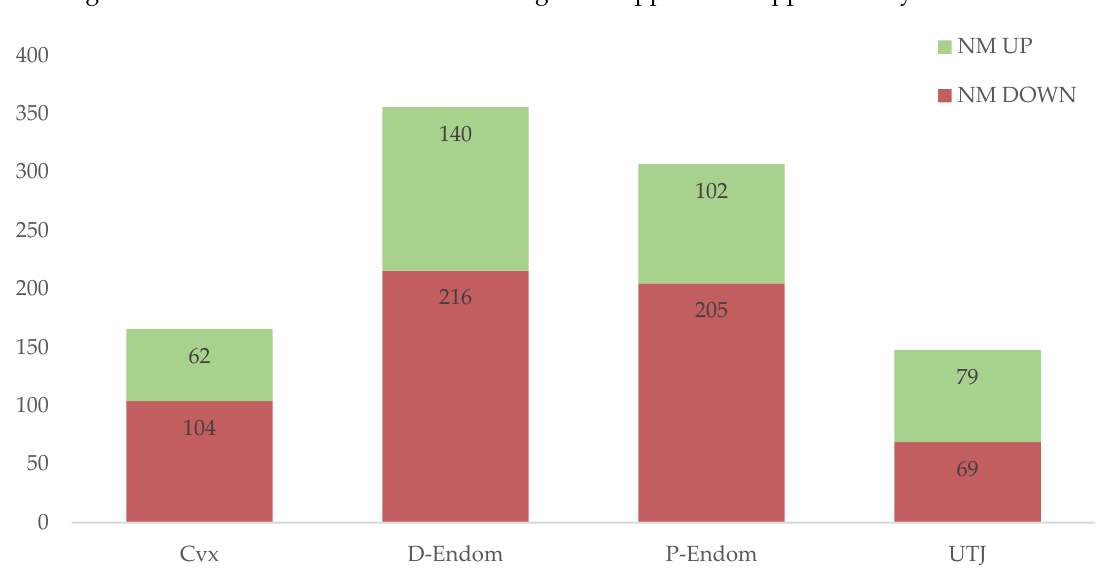
Figure 2. Differential expression (up- and downregulation) of annotated genes solely affected by copulation in the mucosa of the sow uterus (endocervix (Cvx), endometrium (distal: D-Endom or proximal: P-Endom) and the utero-tubal junction (UTJ)). The numbers represent the number of differentially expressed genes ( p -value < 0.05).